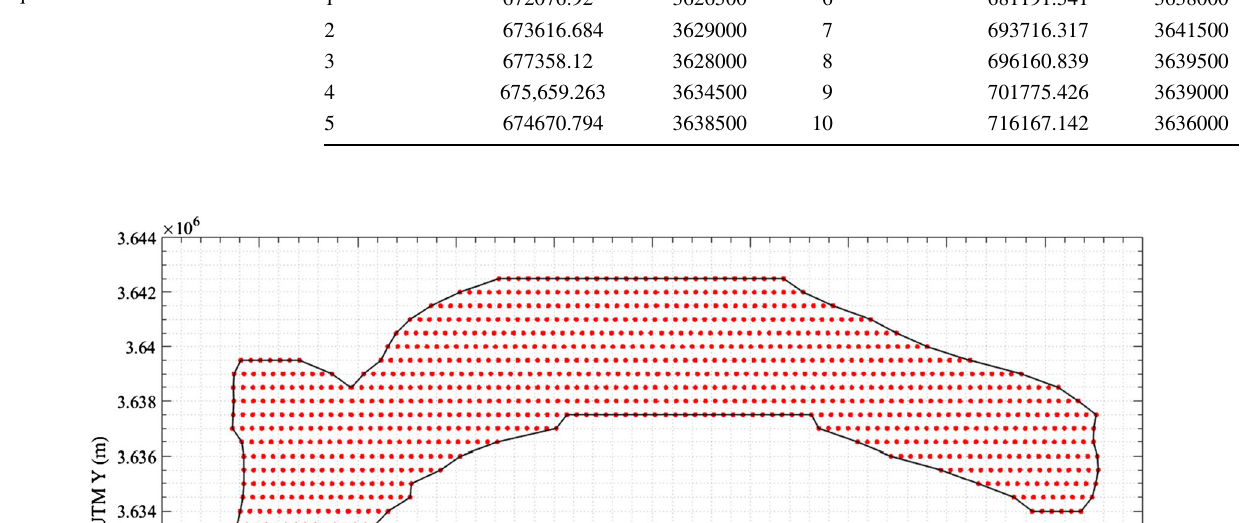
Table 1 Coordinates of observation wells in Birjand aquifer